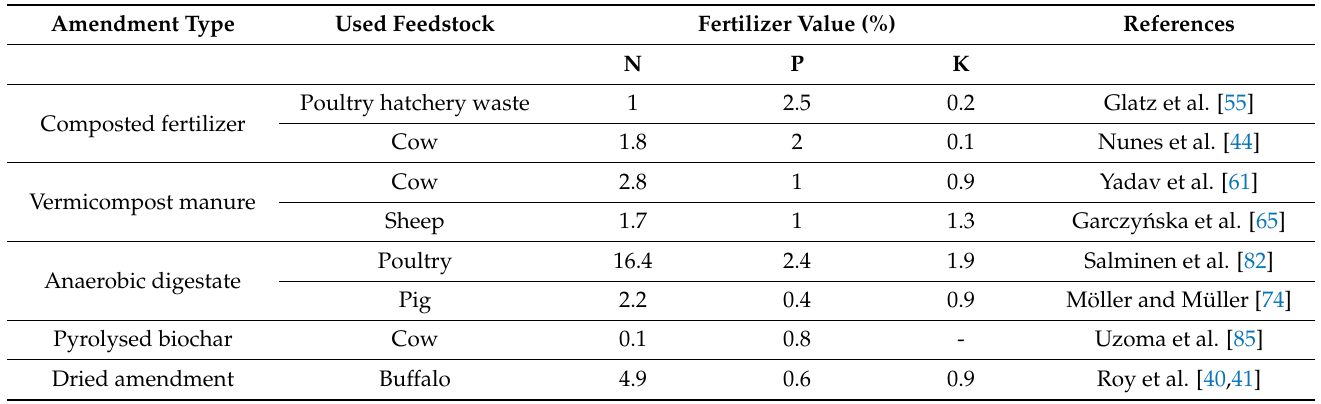
Table 1. Nutritional status of organic fertilizers derived from different animal